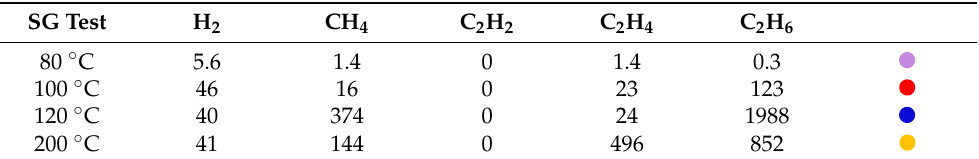
Table 4. SG patterns of DDB oil during SG tests at 80 °C to 200 °C in the laboratory. SG Test